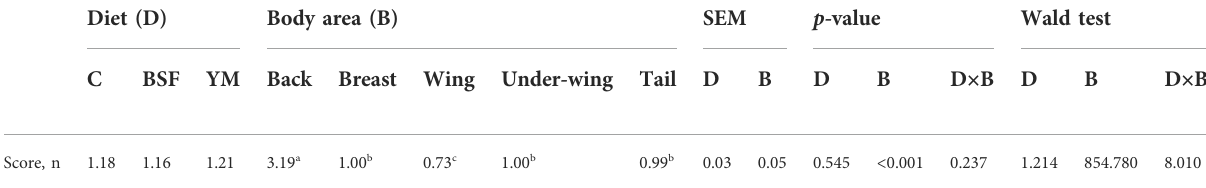
TABLE 2 Feathering score of the broiler chickens depending on diet, body area and their interaction. Diet